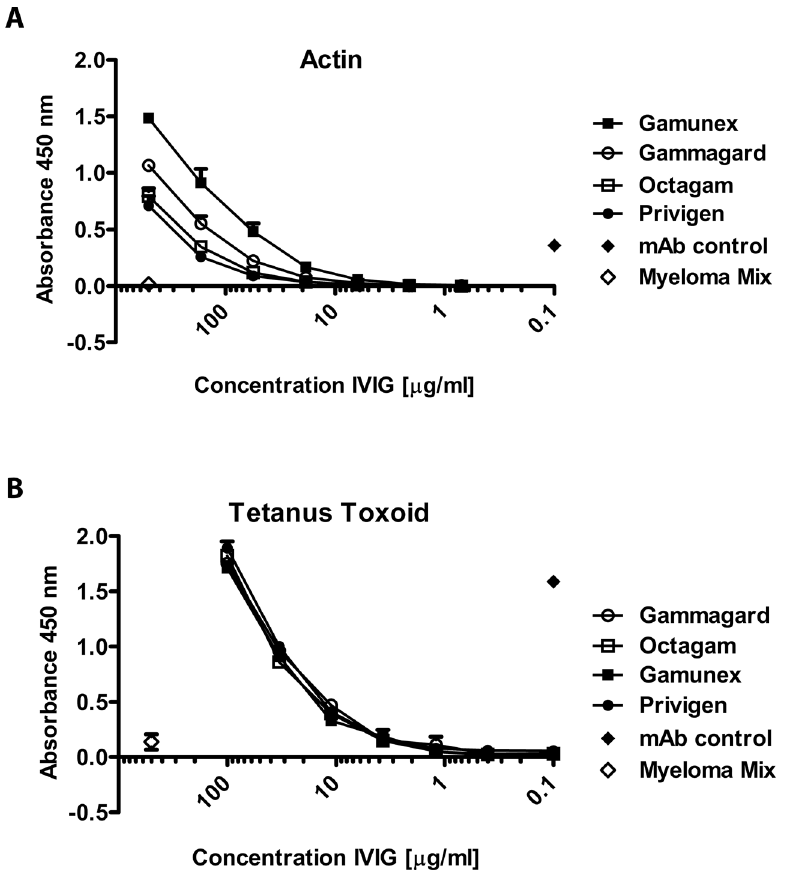
Fig 2. In vitro Comparison of commercial IgG preparations activity to actin and tetanus toxoid by ELISA. ELISA measurement on (A) on plate-bound actin and (B)on immobilized tetanus toxoid. The panel shows combined results from repeated measurements (n = 3) with different